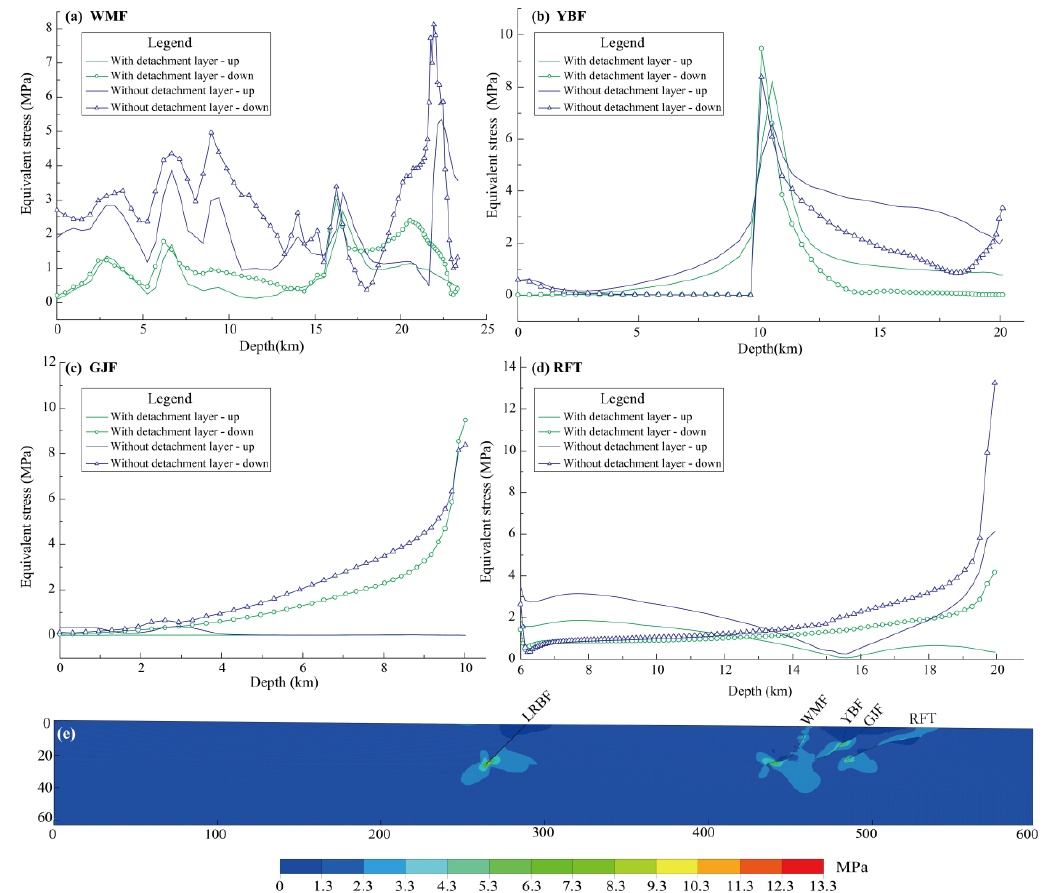
Figure 7. Comparison of cumulative equivalent stress distribution under detachment layer and without detachment layer. ( a – d ) the comparison results on WMF, YBF, GJF, and RFT; Solid line: Equivalent stress on the hanging wall of the fault; Solid Line with dots: Equivalent stress on the footwall of the fault; Green color: Results with detachment layer; Blue color: Results without detachment layer, hanging wall of the fault is simplified to “up” and footwall of the fault is simplified to “down” in the legend. ( e ) is the entire model distribution without the detachment layer; Black line: the faults considered in the model.